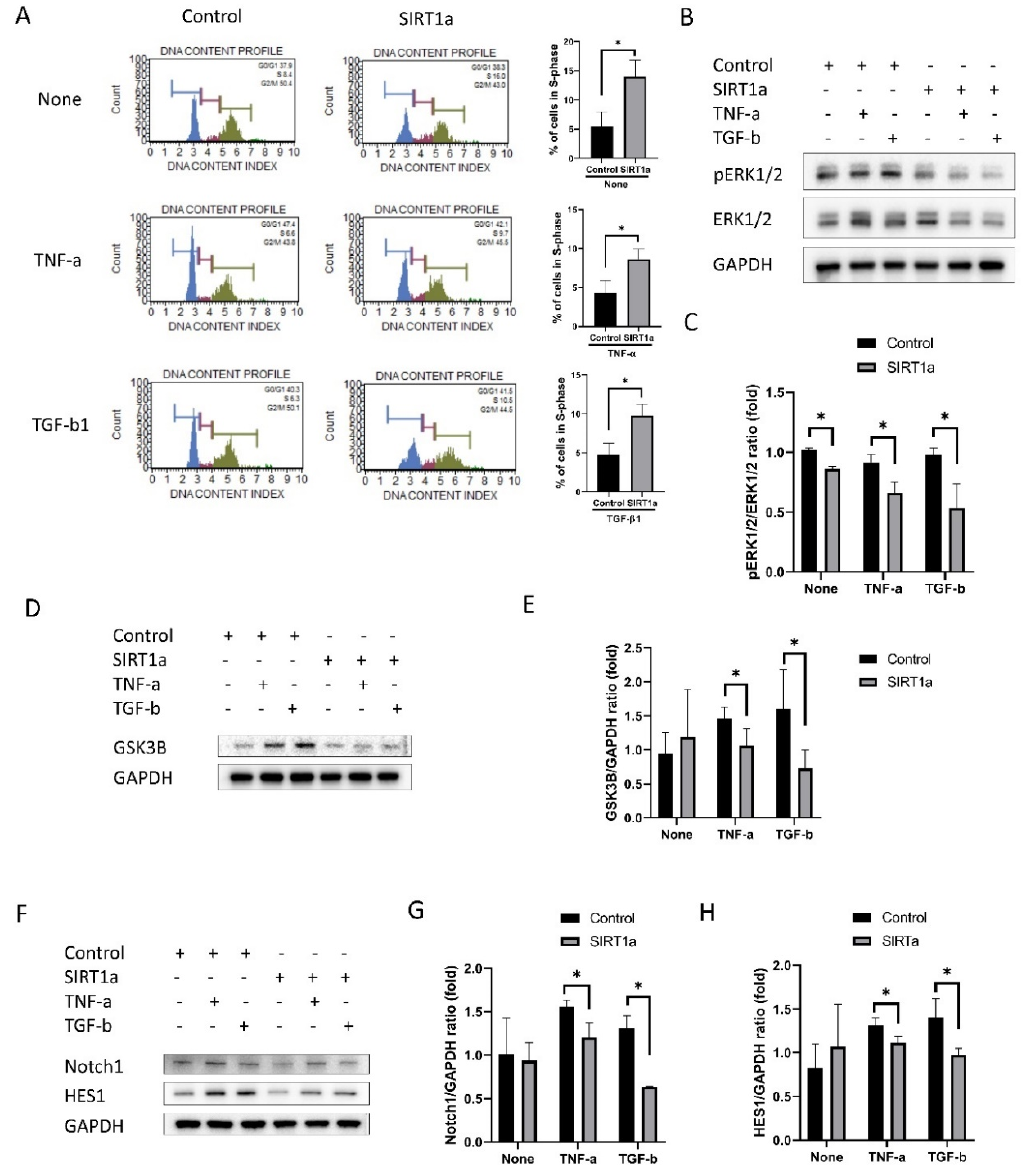
Figure 6. SIRT1 inhibits cytokine-induced cell cycle arrest. ( A ) Cell cycle analysis showed that the number of cells in S-phase was increased in SIRT1a group compared to control in untreated and upon treatment with either tumor necrosis factor-alpha (TNF- α ) and transforming growth factor-beta1 (TGF- β 1). ( B – H ) phospho- extracellular signal-regulated protein kinases 1 and 2, glycogen synthase kinase 3 beta (GSK3 β ), Notch and HES1 levels were reduced in SIRT1a group compared to control upon treatment with TNF- α or TGF- β 1. All experiments were performed in triplicate or quadruplicate. * for p < 0.05 using independent t -test.